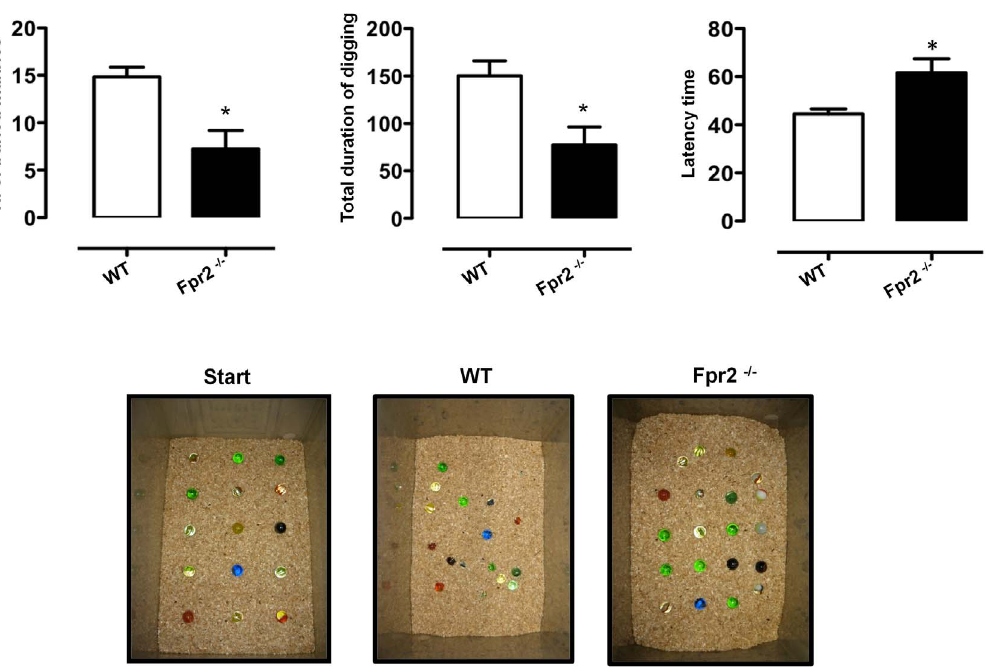
Fig. 4. Reduced digging and marble burying behaviour of Fpr2/3 -/- mice in the marble burying test. The bar graphs and relative pictures show the total number of buried marbles, total duration (seconds) of digging and the latency (seconds) to the first digging bout during a 10-minute trial. Values are expressed as median ¡ S.E.M. and representative of four different experiments involving 6–9 mice per group. * P , 0.05 and ** P , 0.05 indicate significant values compared with wild-type (WT) control mice (Mann–Whitney U -test).